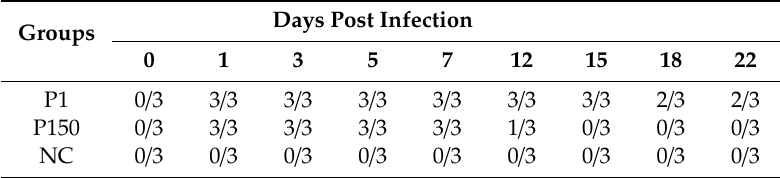
Table 1. Number of nasal swabs from experimental calves positive for Mycoplasma bovis culture.